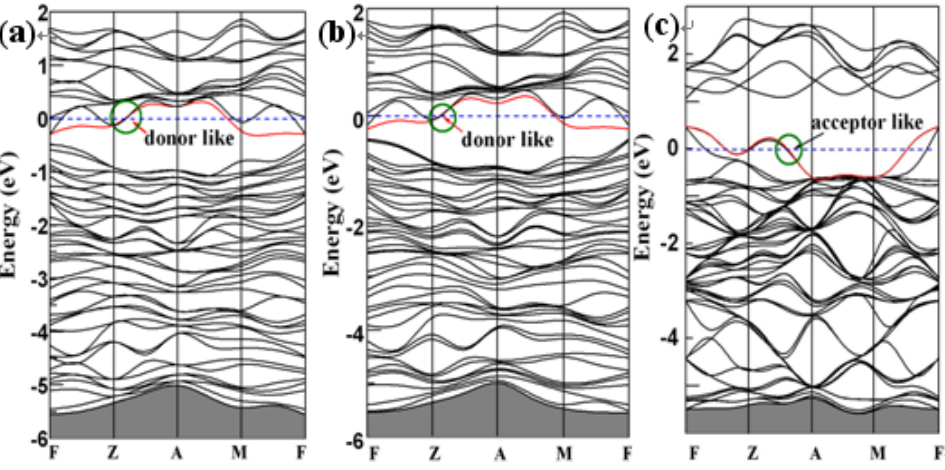
Sb Te (model S3). 64 60 4